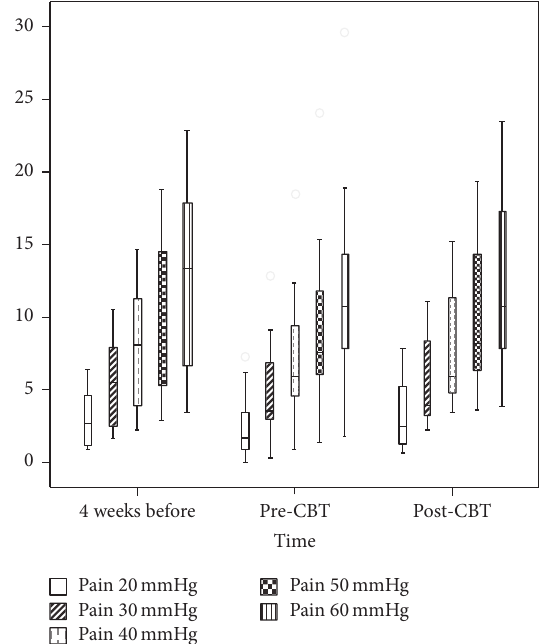
Figure 1: The estimated visceral pain based on ratings made by subjects with IBS at the rectal pressure of 20, 30, 40, 50, and 60 mmHg, respectively, four weeks before CBT, before, and after CBT. The pressure was induced by a barostat